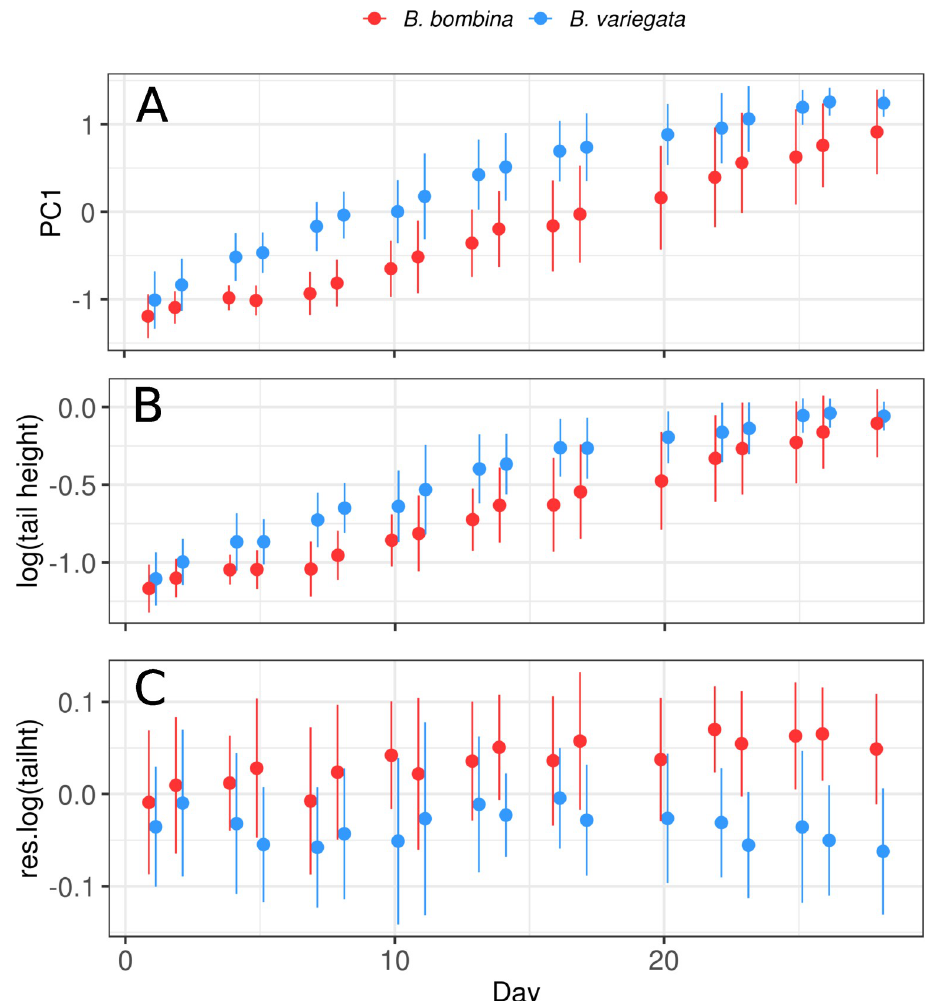
Fig 4. Morphological development by taxon. Means and standard deviations by taxon for each of three descriptors of morphology. A. PC1 = 1. principal component � body size, B. log(tail height), C. residual(log(tail height)) = residuals of a regression of log(tail height) on PC1 � size-corrected tail